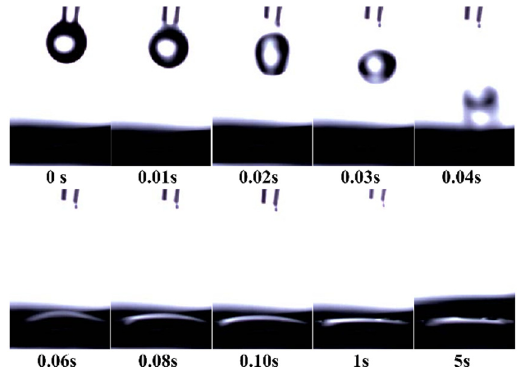
Figure 5. High-speed image sequence of DI water droplet dripping onto the ZnO NWs-PVDF NF layer surface.